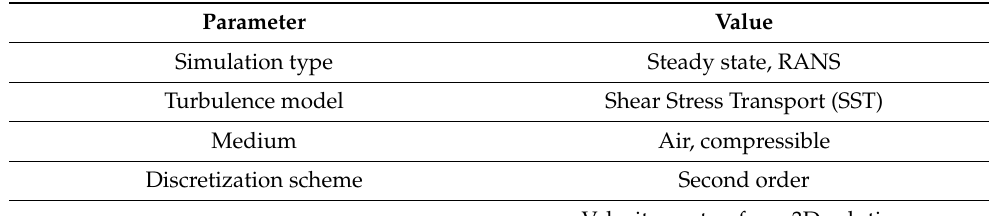
Figure 7. Computational domain with mesh elements and boundary condition regions. Table 2. Numerical model settings for the 2D simulations.